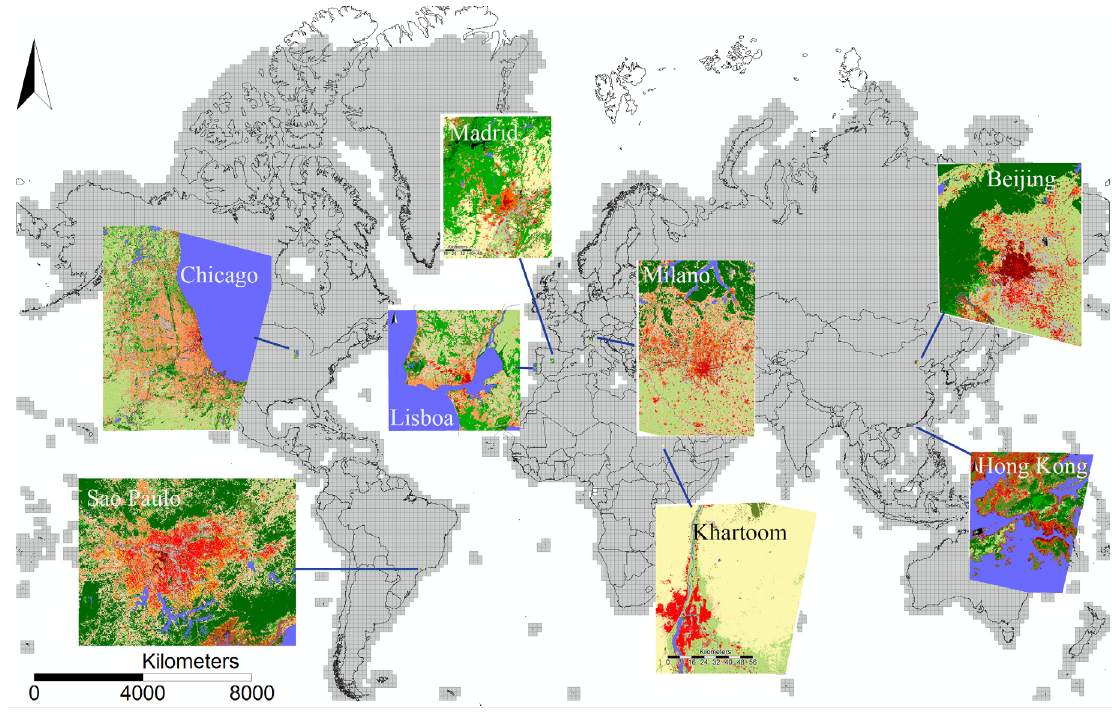
Figure 1. Local Climate Zone classifications of selected cities (WUDAPT.org). Grey: GHSL LABEL tiles.